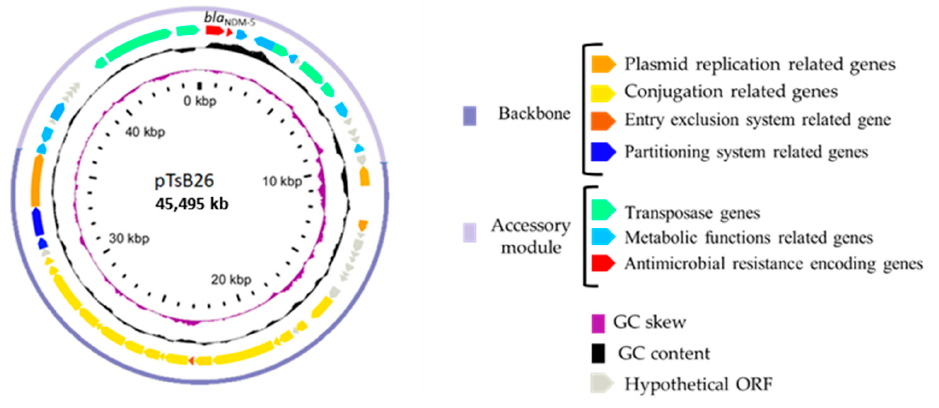
Figure 1. pTsB26 plasmid representation.